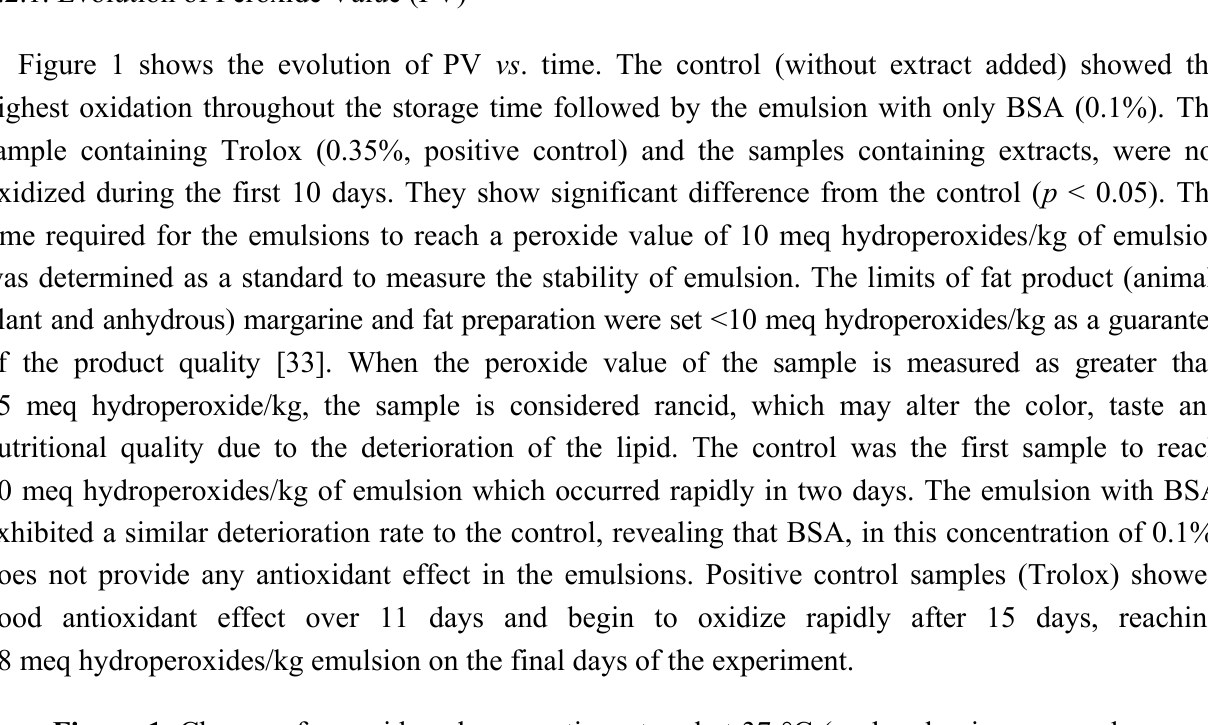
Figure 1. Change of peroxide value over time stored at 37 °C (each value is expressed as mean ( n =